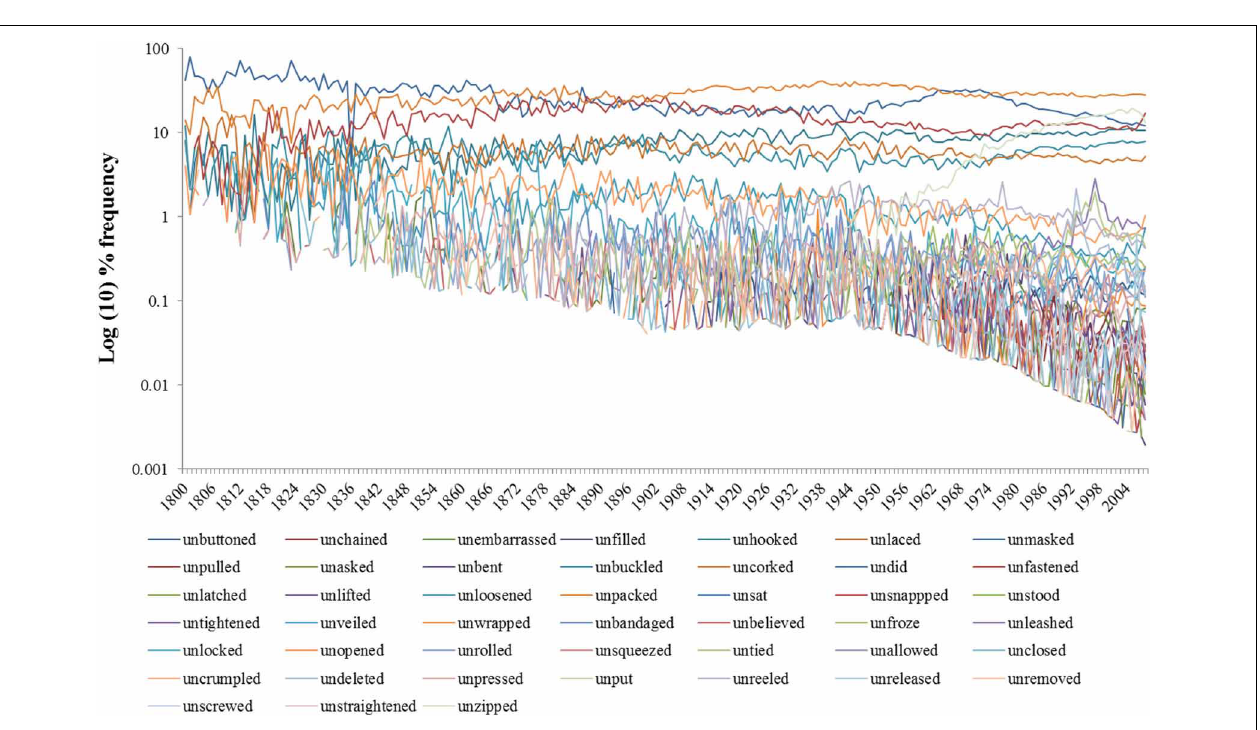
FIGURE A2 | Historical trends of un-form